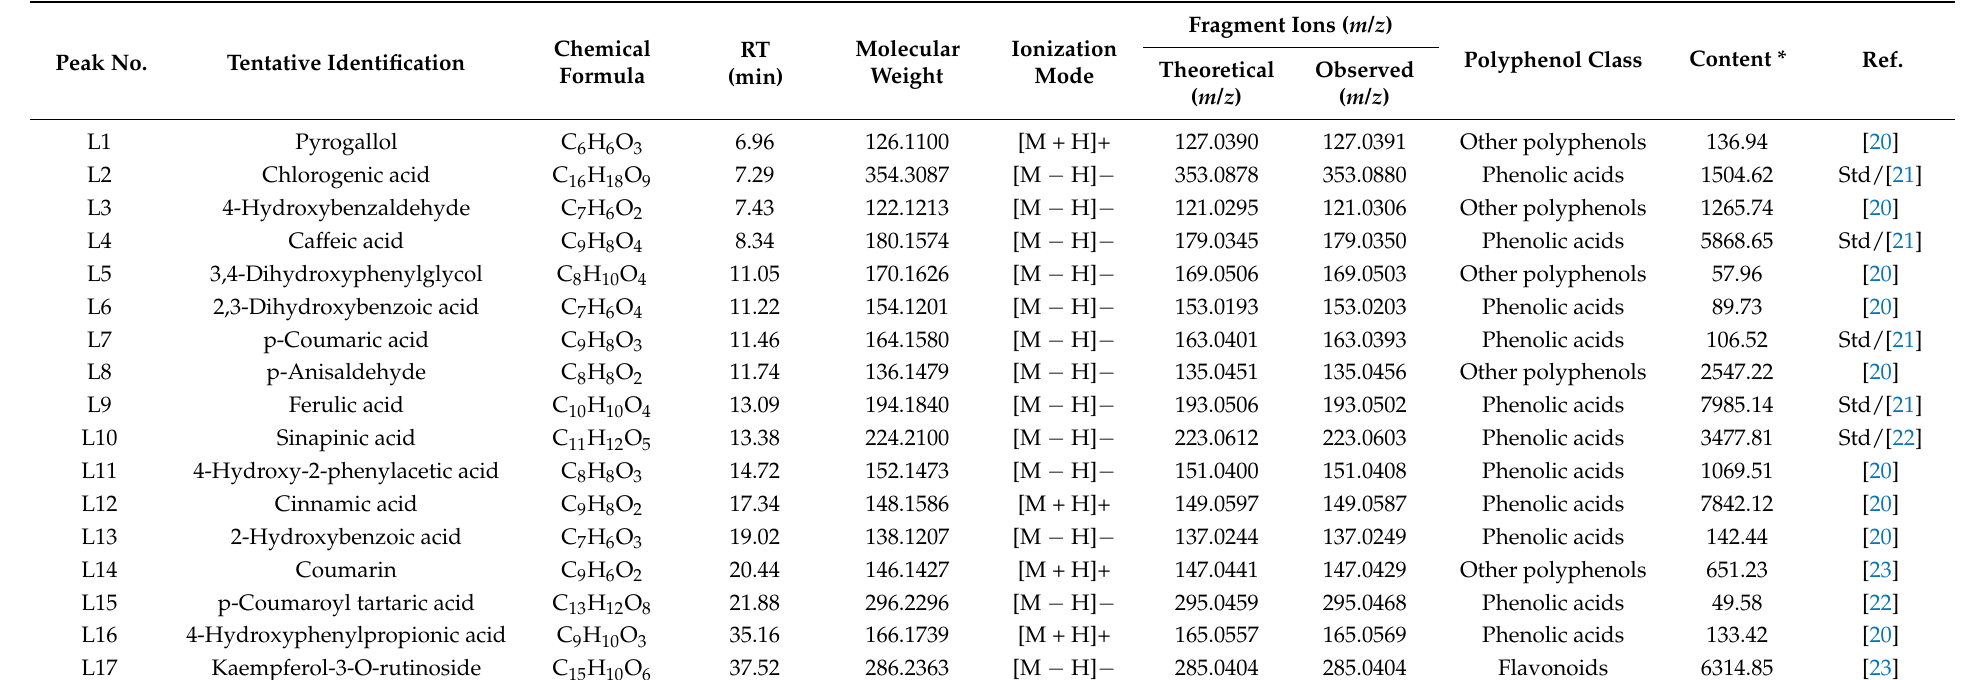
Table 1. Identification and quantification of the different compounds present in A. vulneraria leaf extract using HPLC-MS.